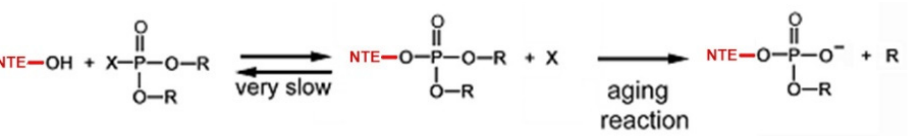
Figure 1. Interaction of neuropathic OPs with NTE. The hydroxyl group at the active site serine reacts with the phosphorus atom of the OP, resulting in the phosphorylation of NTE and the dephosphorylated OP (X). During the aging reaction, an R group from the phosphate moiety of NTE is released, resulting in a negative charge. Due to the aging reaction not being reversible, this results in the permanent inhibition of NTE’s esterase activity.